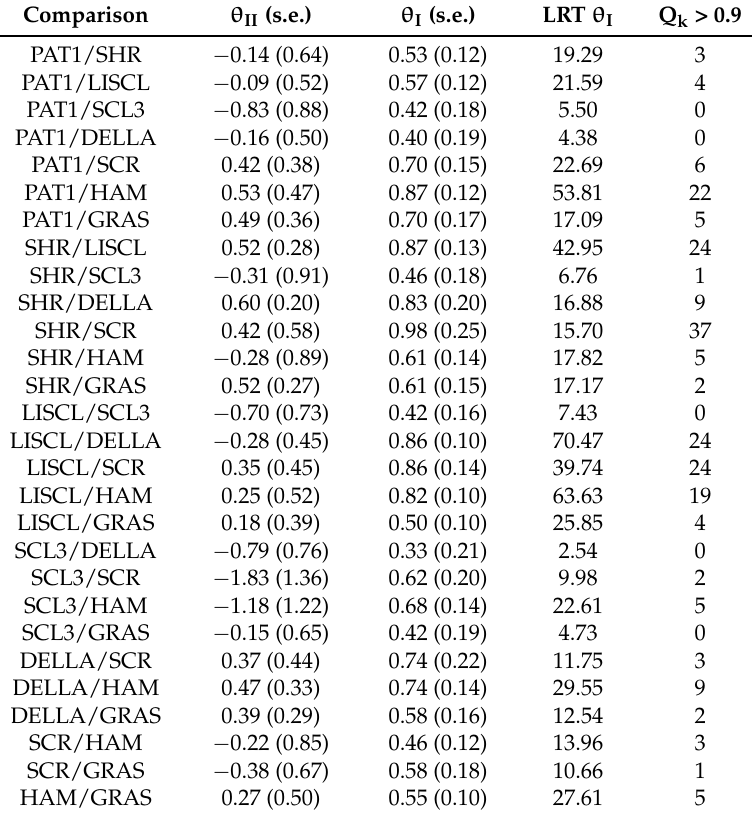
Table 1. Functional divergence between subfamilies of GRAS